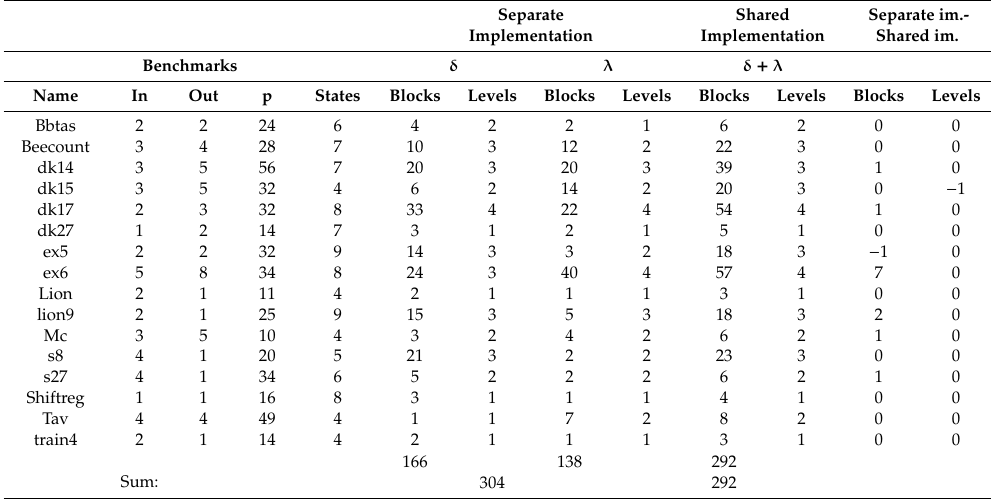
Table 1. Results of experiments (ABC, number of states < 10).